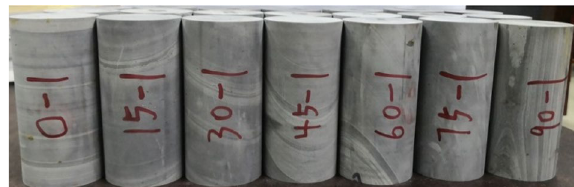
Figure 1. Phyllite samples.